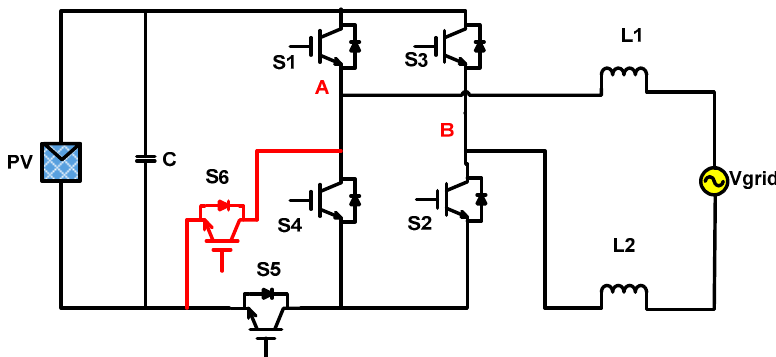
Figure 2. Novel H6 transformerless inverter.